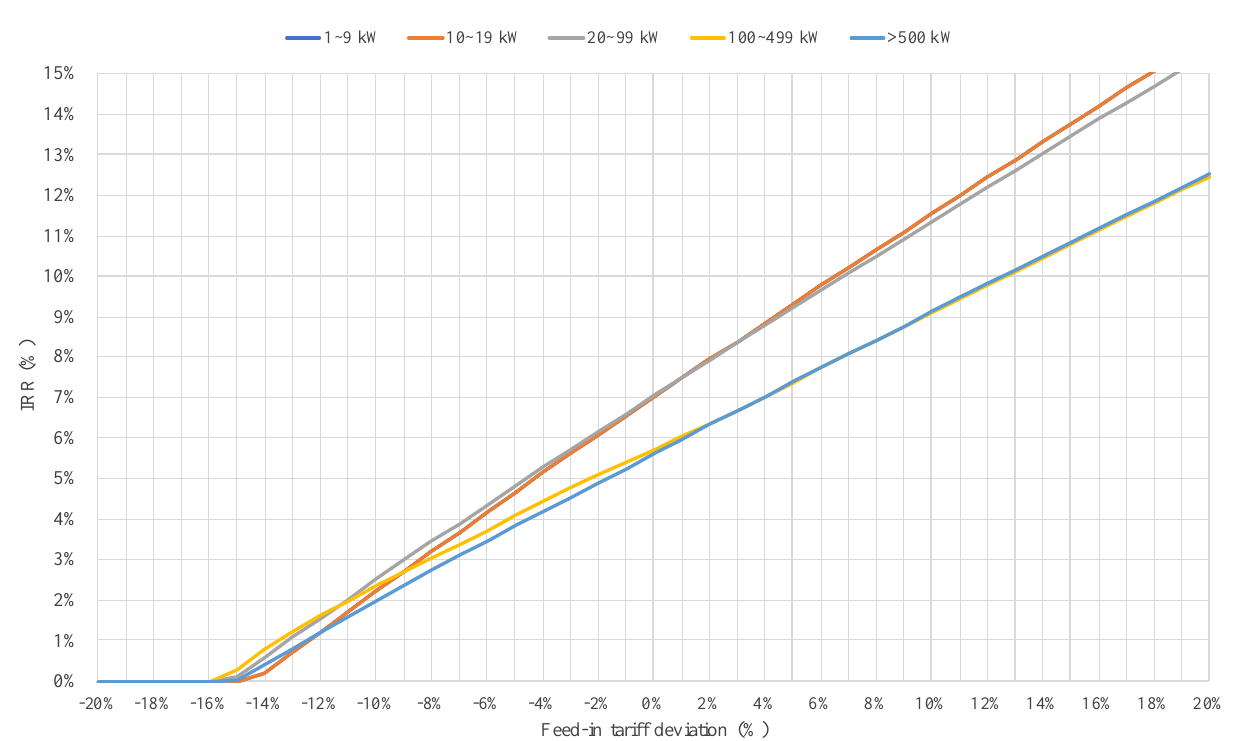
Figure 8. Predicted equity IRR and FIT deviation for PVS with the contract in 2030. Source: self-elaboration.